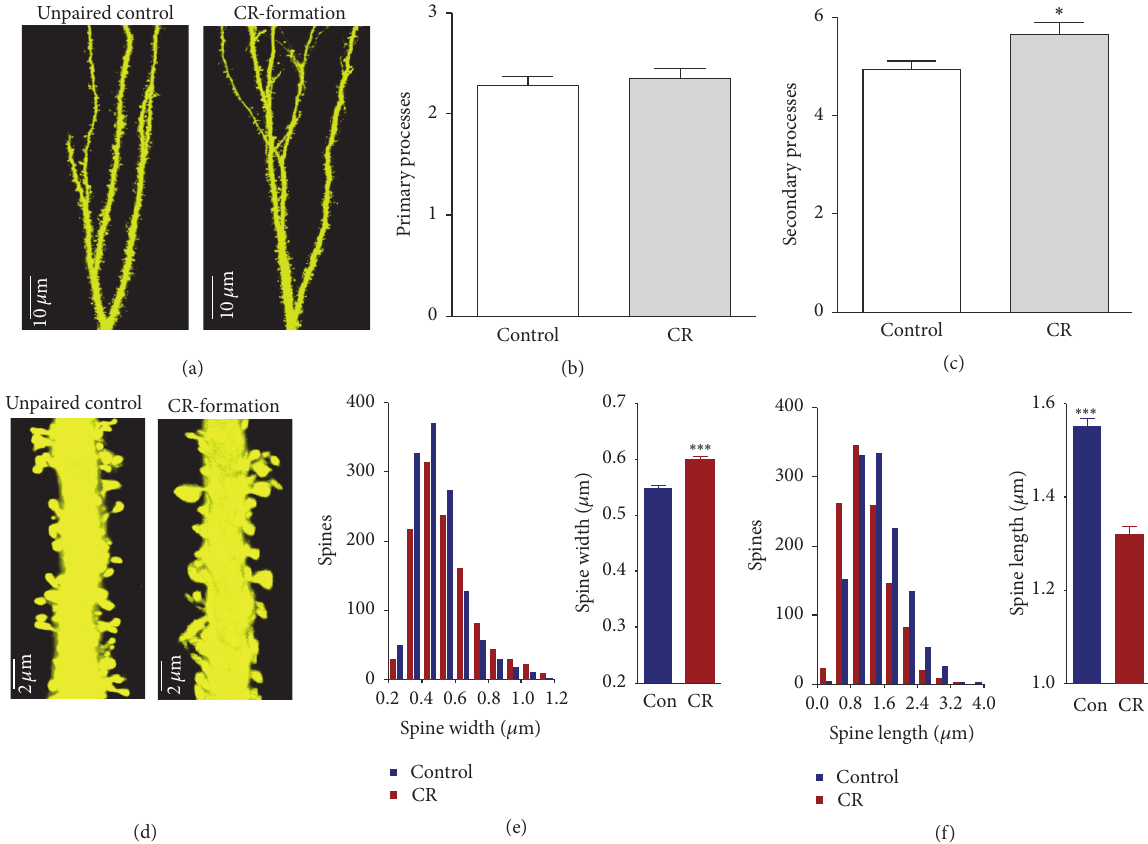
Figure 2: The number of dendrites and the head of the spines on barrel cortical glutamatergic neurons are upregulated after associative leaning. (a) shows the branches of the secondary processes appear denser in CR-formation mouse (right panel) than controls (left). (b) shows the comparisons of primary processes per apical dendrite in CR-formation (gray bar, 𝑛 = 20 neurons) and controls (white; 𝑝 = 0.3 , 𝑛 = 25 ). (c) shows the comparisons of the secondary processes per apical dendrite in CR-formation (gray bar, 𝑛 = 20 neurons) and controls (white; asterisk, 𝑝 < 0.05 , 𝑛 = 25 ). (d) The spine volume appears larger and the spine length is shorter on CR-formation neurons (right panel) than controls (left). (e) ∼ (f) show the comparisons of spine widths (e) and lengths (f) from CR-formations (red bar, 𝑛 = 1162 ) and controls (Con; blue bar, 𝑛 = 1273 ). The spine head tends to be large and the spine length tends to be short (three asterisks, 𝑝 < 0.001